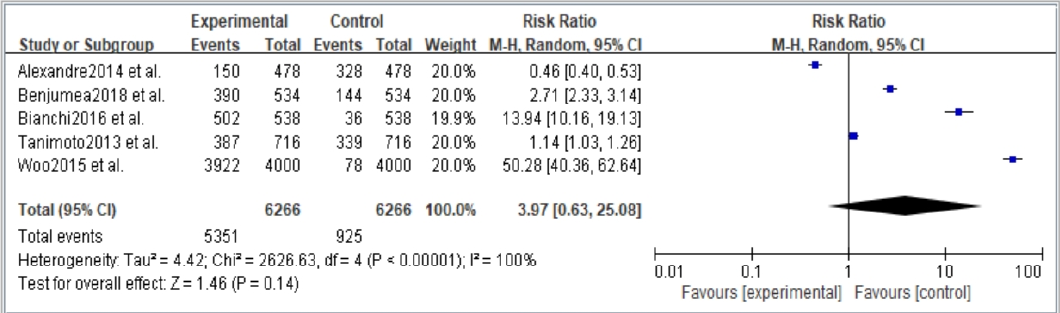
Figure 5. Summary estimates for the sarcopenia status compared to disability outcome.